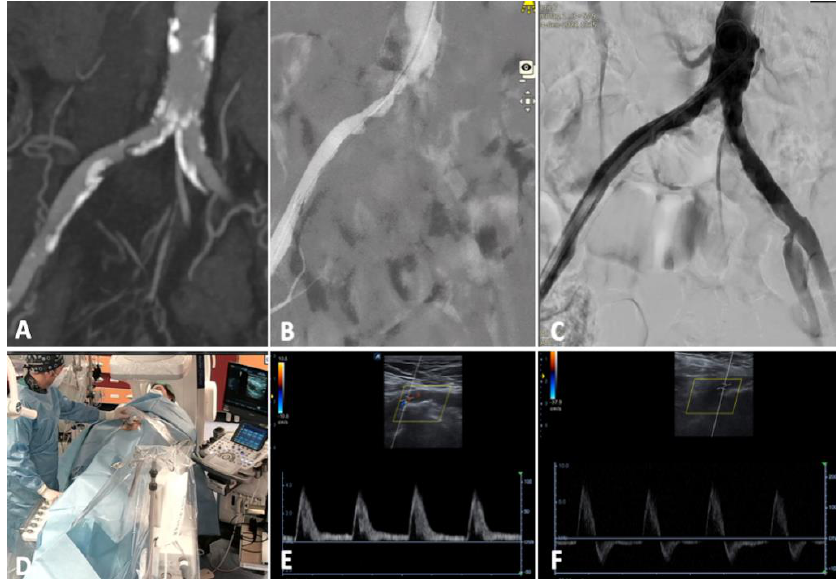
Figure 4. Case 2, right common iliac artery calcified stenosis treated by IVL stand-alone therapy from right femoral access. ( A ) Preoperatory CT scan.; ( B ) initial angiogram; ( C ) completion angio- gram; ( D ) EVUS with preoperative ( E ) and postoperative ( F ) waveforms, changing from monopha- sic to biphasic